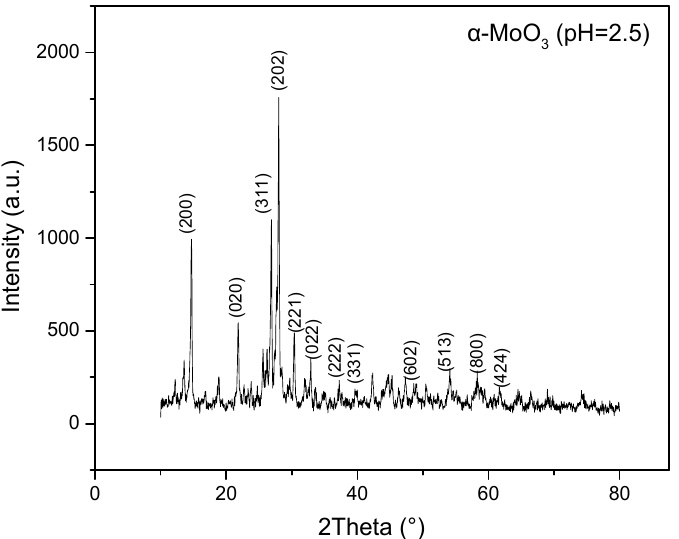
Figure 4. XRD pattern of α -MoO 3 under the synthesis conditions pH = 2.5, T = 90 °C, medium stirring rate (350 rpm).